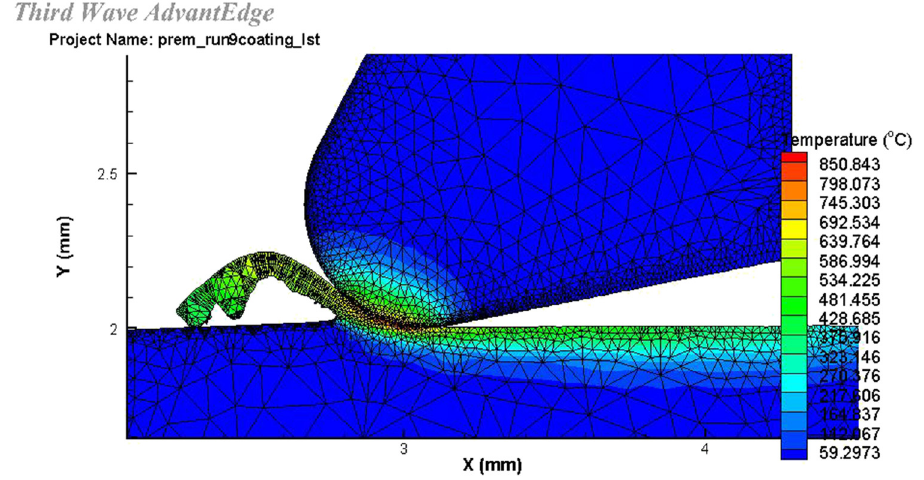
Figure 2: Simulated temperature fi eld for sample no.